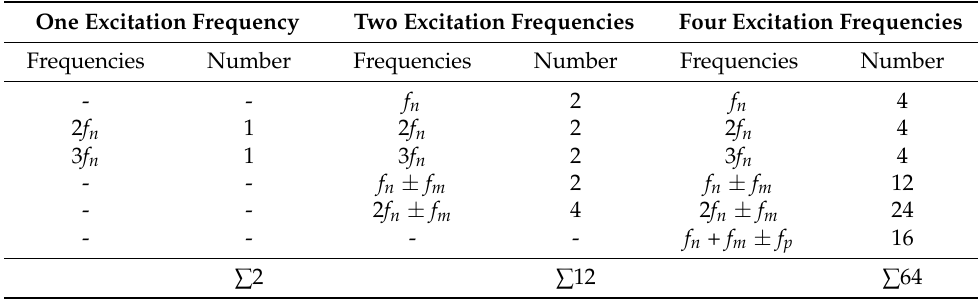
Table A1. Comparison—nonlinearity